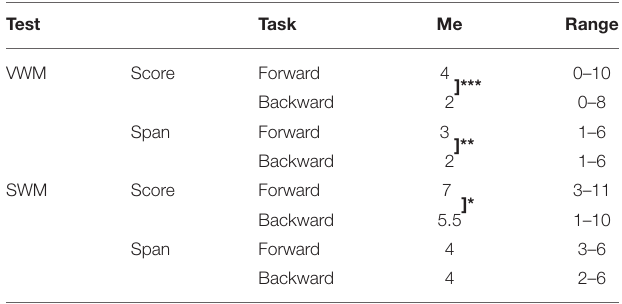
TABLE 4 | Descriptive statistics for VWM and SWM on forward and backward tasks: medians (Me) and ranges of obtained scores and